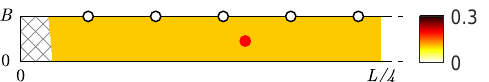
Figure 22. Maximum horizontal random measurement error of the drone camera. The red dot is the initial position of the drone. The hatched area represents the part of the bridge deck that is outside the FOV of the camera. Colorbar expressed in meters.